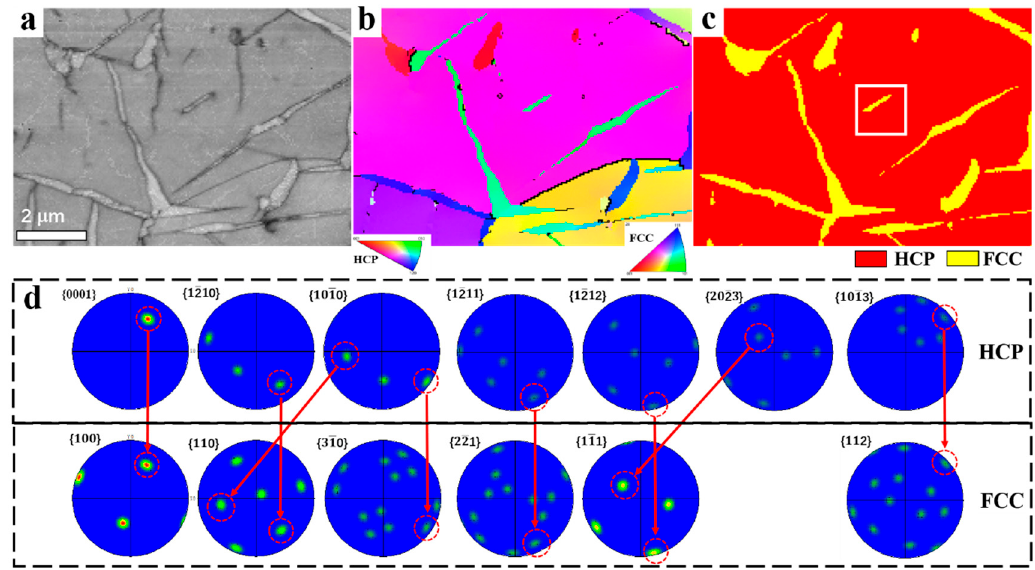
Figure 5. TKD of the HCP-Ti and FCC-Ti phases. ( a ) Band contrast (BC); ( b ) inverse pole figure (IPF), ( c ) Phase mapping, the red part is HCP-Ti phase and the yellow part is the FCC-Ti phase; ( d ) PFs of the two phases.